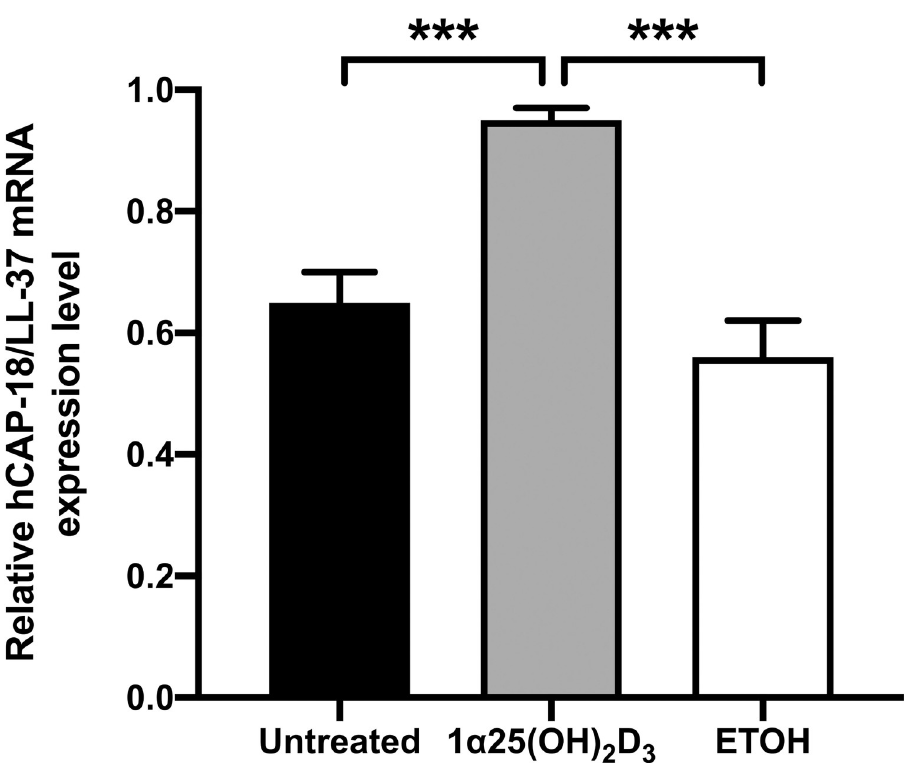
Fig 3. Expression of hCAP-18/LL-37 mRNA in 1 α ,25(OH) 2 D 3 -pretreated A549 cells. A549 cells were incubated with 10 − 6 M 1 α ,25(OH) 2 D 3 for 24 h. The expression of target genes was determined using quantitative RT-PCR. The relative quantitation of each gene was normalized to GADPH. The results are shown as mean ± SD from three independent experiments carried out in triplicate and presented as relative ratio. ��� P < 0.001.